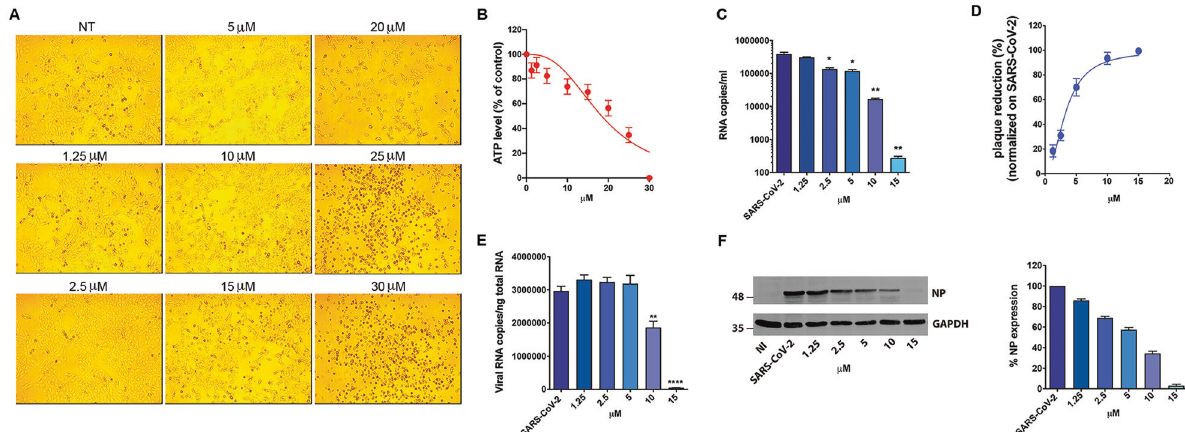
Fig. 1 Effect of raloxifene on Vero E6 cells. Vero E6 cells were cultured for 48 h in the absence or in the presence of raloxifene at different concentrations. A 10× bright ‐ fi eld images of Vero E6 cells after incubation for 48 h at 37°C with the indicated raloxifene concentrations. B CellTiter- Glo was used to measure the antimetabolic effect of raloxifene. C-F Vero E6 cells were infected with SARS-CoV-2 and cultured in the absence or in the presence of different doses of raloxifene. C Viral yield in cell supernatants was quantitated by qRT-PCR. D Viral titer in cell supernatants was evaluated by plaque assay and plotted as percentage of plaque reduction compared to SARS-CoV-2. E Quantitation of SARS-CoV-2 genomes at the intracellular level by qRT-PCR. F NP expression in infected cells was analyzed by western blot (left panel). Densitometric analysis of western blot is shown in the right panel. Graph represents the percentage of NP expression. All the experiments were performed at least in three independent replicates and pictures shown are representative. Data are presented as the mean ± standard error of the mean * P < 0.05; ** P < 0.01; **** P <